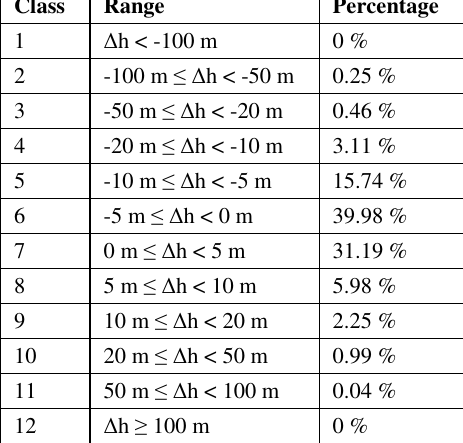
Table 6. HR-LR height differences in the